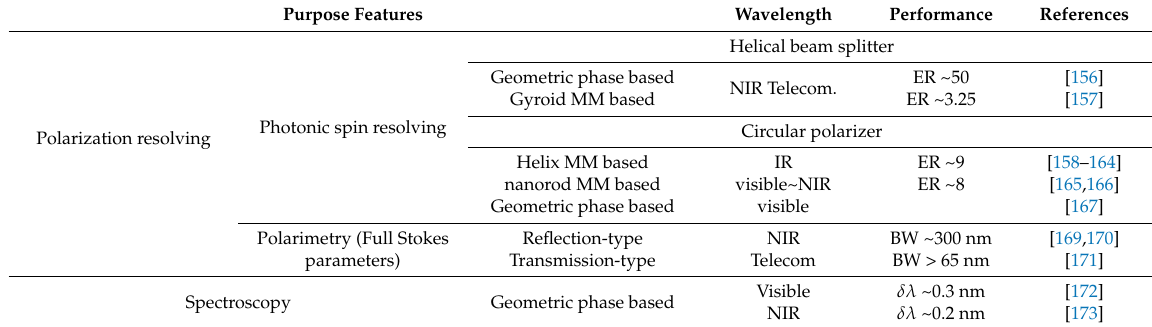
Table 3. Flat optic devices based on MMs and MSs for characterization of light